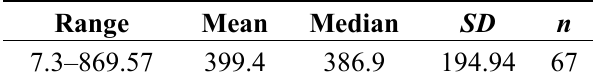
Table 1. Summary statistics of the timber volume observed at the 67 terrestrial sample plots (given in m 3 ha − 1